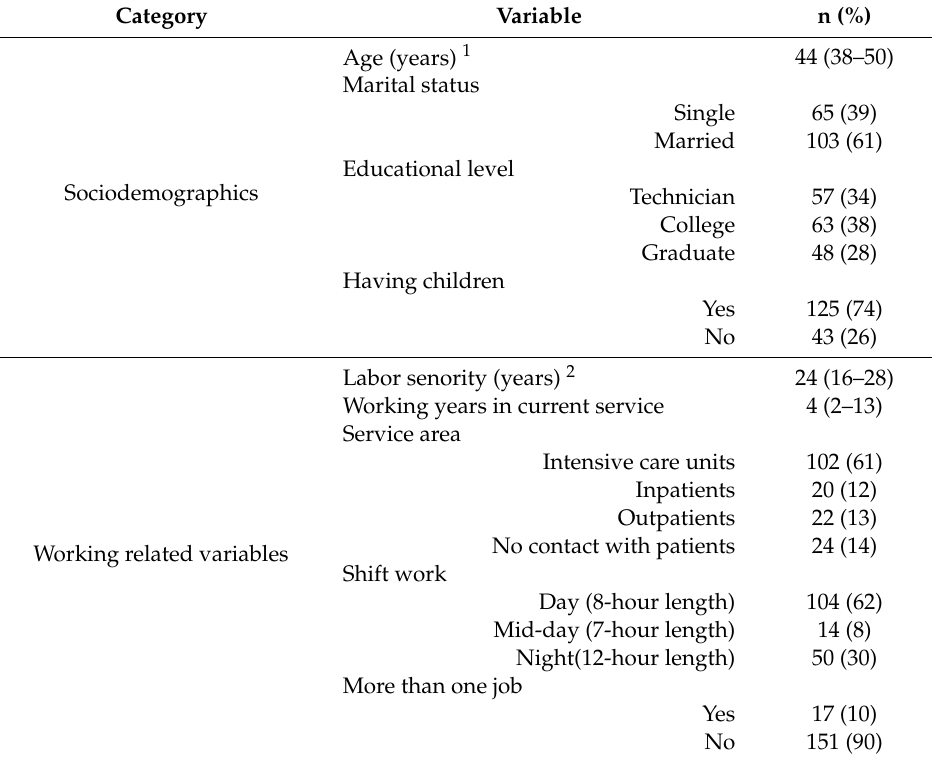
Table 1. General characteristics of the total sample of